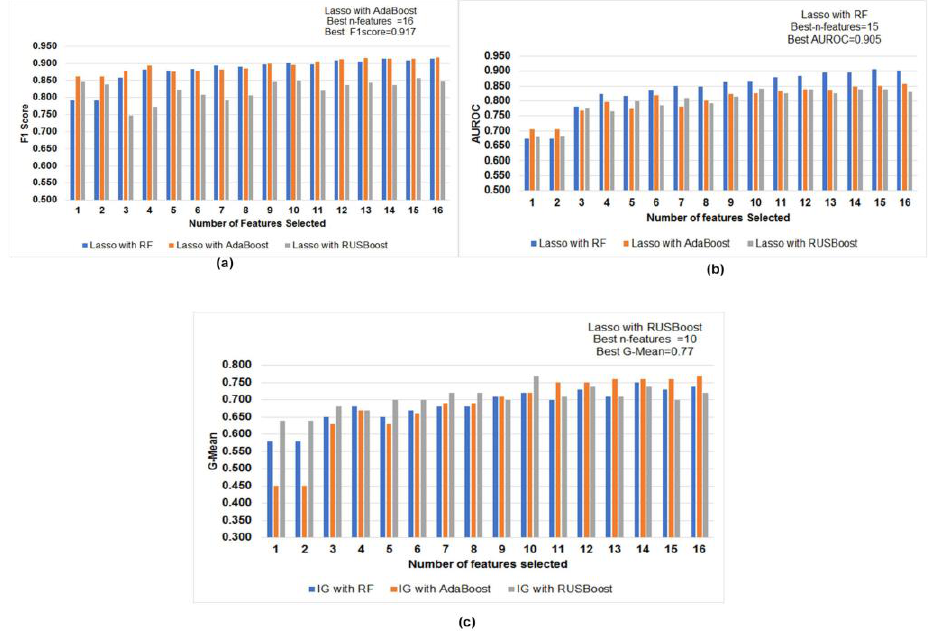
Figure 3. ( a – c ): Comparative evaluation of performance measures ( a ) F1-score ( b ) AUROC ( c ) G-Mean in models built using a different subset of features using lasso.